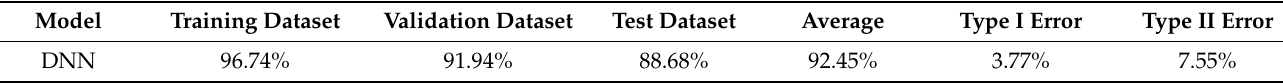
Table 8. Accuracy of the DNN model.